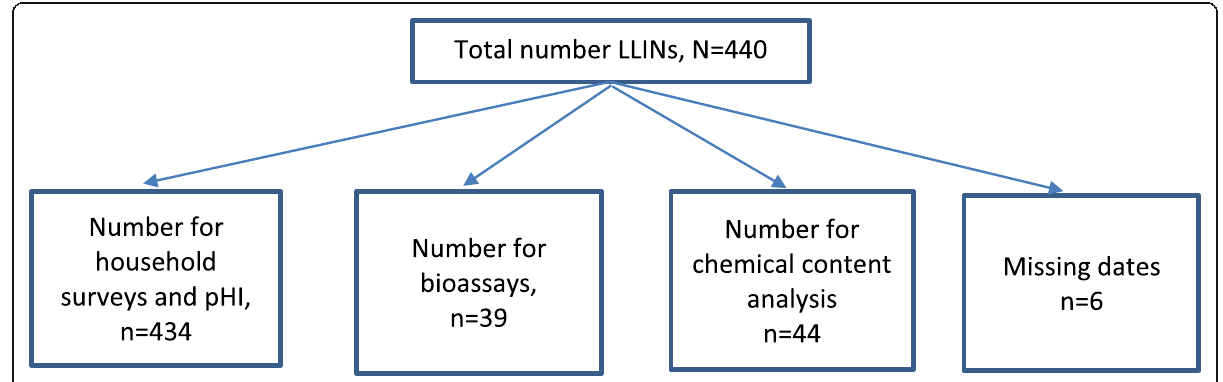
Fig. 1 Flow chart of LLIN records collected for household, pHI, bioassays, and chemical analysis